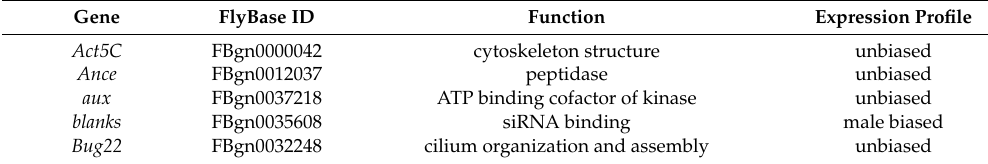
Table 1. Genes belonging to the ontology category “sperm individualization” (GO:0007291) in insects. Genes are identified by their names and their corresponding FlyBase ID in the Drosophila melanogaster genome. Information on the general function of the gene and sex biases in expression profiles is also